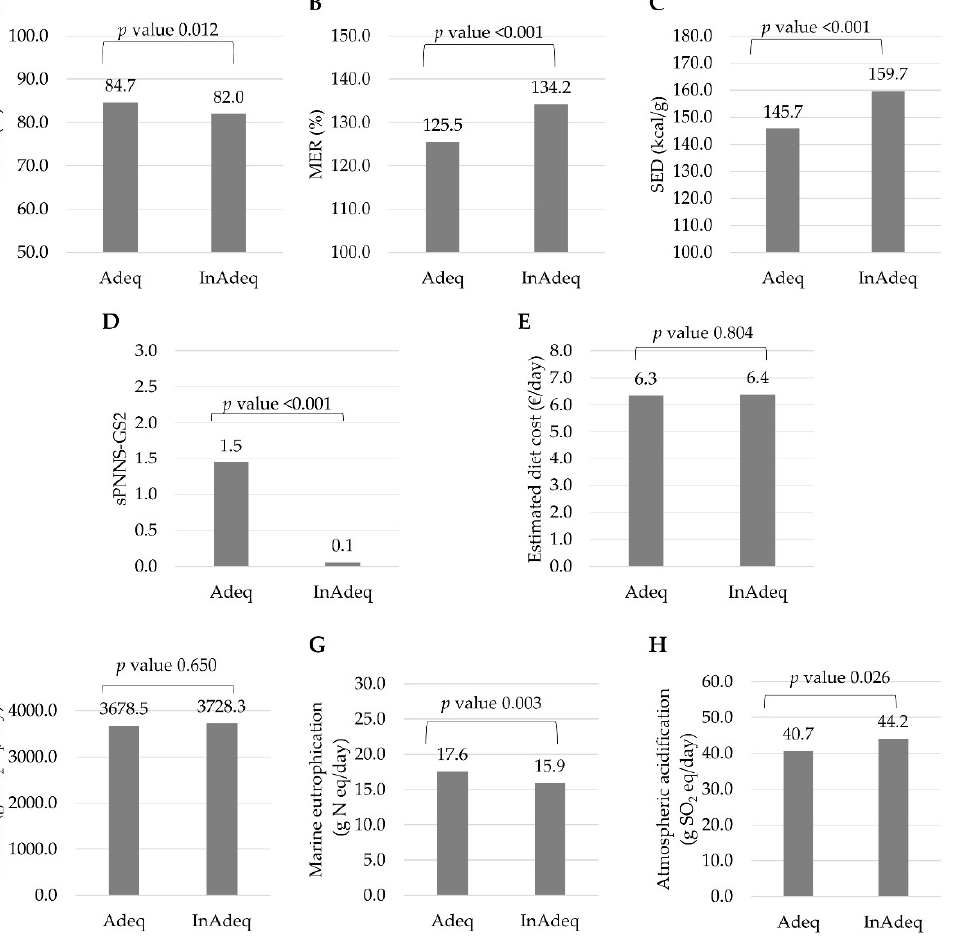
Figure 1. Nutritional quality (panel A : mean adequacy ratio; panel B : mean excess ratio; panel C : solid energy density; panel D : sPNNS-GS2) and environmental (panel F : greenhouse gas emissions; panel G : marine eutrophication; panel H : atmospheric acidification) indicators and estimated diet cost (panel E ) of observed diets fulfilling (Adeq) and not fulfilling (InAdeq) the recommended guideline for pulses (equivalent to 57 g/day). Values are means adjusted for energy intake, gender, and diet status. MAR, Mean adequacy score; MER, Mean excess ratio; SED, Solid energy density; sPNNS-GS2, simplified Programme National Nutrition Santé Guideline Score 2; GHGE, Greenhouse gas emission.